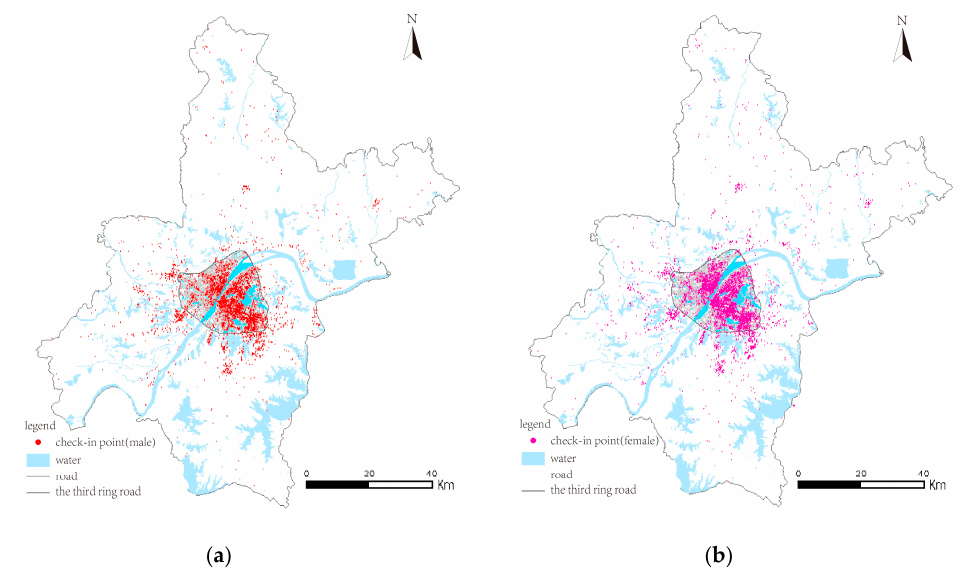
Figure 2. Distribution of the data points: ( a ) Distribution of male Weibo users’ check-in points in Wuhan; ( b ) distribution of female Weibo users’ check-in points in Wuhan.